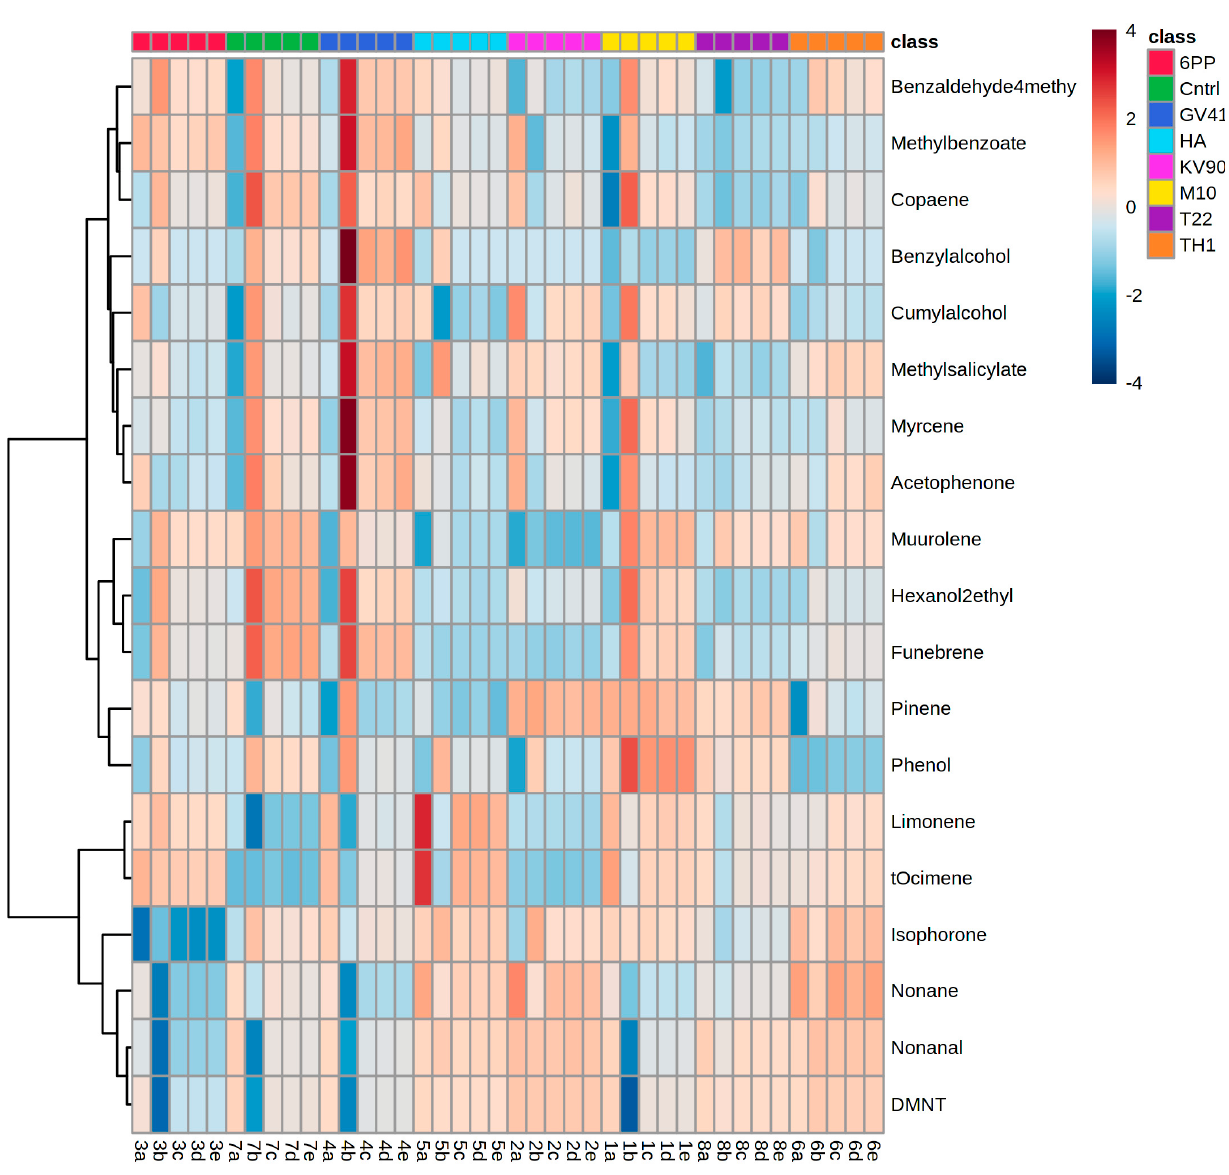
Figure 2. Hierarchical clustering heat map of differential volatile compounds produced by olive trees. Each column represents the samples obtained by plants treated with Trichoderma spores (M10, TH1, T22, KV906, and GV41,) or metabolites (6PP and HA). Water-treated plants served as controls (CTRL). In the heat map, red and blue colors indicate higher and lower chemical abundance, respectively. Treatments are indicated according to the color scale (class) shown in the legend at the top right. Data are presented as individual values from each biological replication. Statistical differences were determined using one-way ANOVA ( p < 0.05).